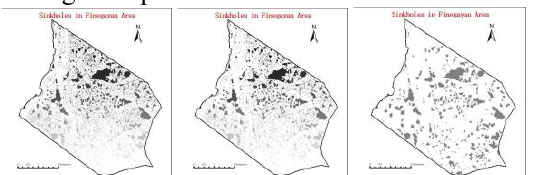
Figure 3. Sinkholes in Finegayan Area. Top: All land depressions; Center: Land depressions more than 10 m 2 ; Bottom: Preliminary Sinkholes.